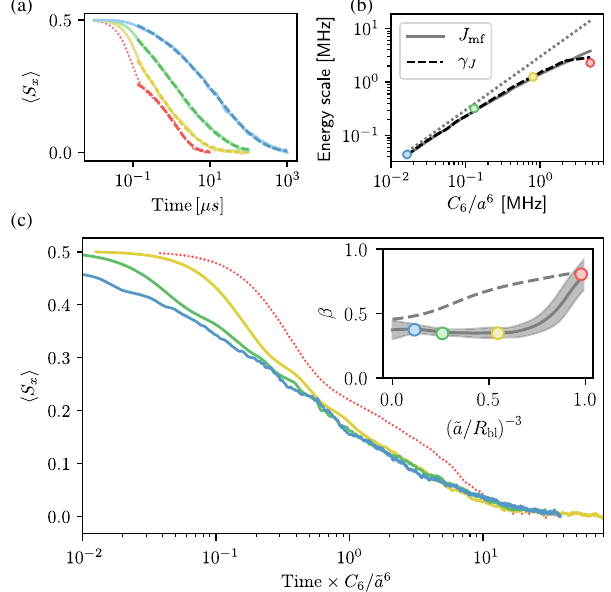
FIG. 6. Numerical simulation of the dynamics for a uniform density distribution using the DTWA. (a) The simulated dynam- ics before rescaling. After the quadratic onset, the magnetization decay is fitted well by the stretched exponential function (dashed lines). (b) The fitted decay rate γ (dashed black line) agrees well J with the median of the mean-field interaction strengths J (solid mf gray line), which is the typical energy scale of the system. In the weakly interacting limit, J scales linearly with C 6 =a 6 (dotted mf gray line). The colored dots denote the decay rate derived from the four simulations depicted in (a). (c) For small 1 . 25 × 10 8 cm − 3 , blue line and blue dot in the inset) ( ρ S ¼ 3 . 51 × 10 8 cm − 3 , green line and intermediate densities ( ρ S ¼ 8 . 73 × 10 8 cm − 3 , yellow line and green dot in inset and ρ S ¼ and yellow dot in the inset), the numerical data collapses on one curve after rescaling time with C 6 = ˜ a 6 , where ˜ a plays the role of an effective distance that takes into account the roles of disorder and power law interactions. For densities as large as ρ S ¼ 2 . 11 × 10 9 cm − 3 (dotted red line and red dot in the inset), the spatial order introduced by the blockade is so large that the dynamics does not follow the universal behavior observed for smaller densities. Inset: disorder averaged stretching exponent β (solid line) as a function of the order in the system expressed by ð ˜ a=R bl Þ − 3 . Below a critical value of ð ˜ a=R bl Þ − 3 ≲ 0 . 7 the exponent becomes constant. The shaded area indicates statistical uncer- tainty. The dots denote the exponent β resulting from the single disorder realizations of (a). The dashed line is obtained from the fluctuator model [see Eq. (6) in Sec.